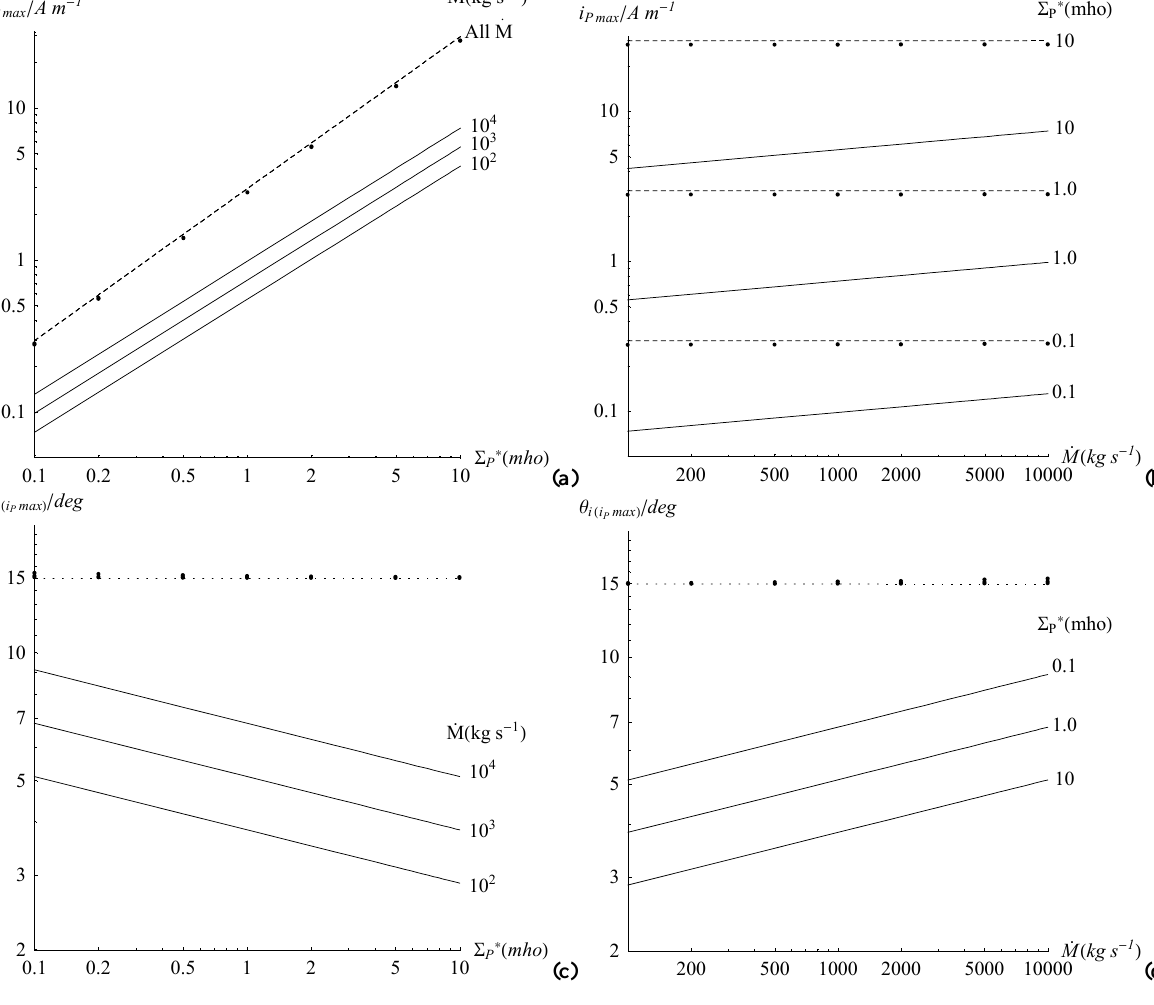
Fig. 9. Plots showing the magnitude and location of the peak height-integrated Pedersen current intensity in the ionosphere, and their dependence on 6 ∗ and ˙ M . Plot (a) shows the magnitude of the peak Pedersen current plotted versus 6 ∗ in log-log format for ˙ M = 100, P P 1000 and 10000kgs − 1 , while plot (c) show the ionospheric location of the peak. Plots (b) and (d) similarly show the magnitude and = 0 . 1, 1 and 10mho. Solid lines give results for the dipole field obtained location of the peak Pedersen current plotted versus ˙ M for 6 ∗ P from Eq. (21a), while the dashed lines show corresponding results derived from the approximate solutions for the power law current sheet field given by Eq. (34a). The solid dots show spot values obtained from numerical integration using the full current sheet solution. For the case of the current sheet approximation the peak current depends only on 6 ∗ and not on ˙ M , so that only one dashed line is shown in plot P (a), valid for all ˙ M . The peak current in this case always occurs at the poleward boundary of the current sheet field lines, as indicated by the horizontal dotted lines at ∼ 14.95 ◦ in plots (c) and